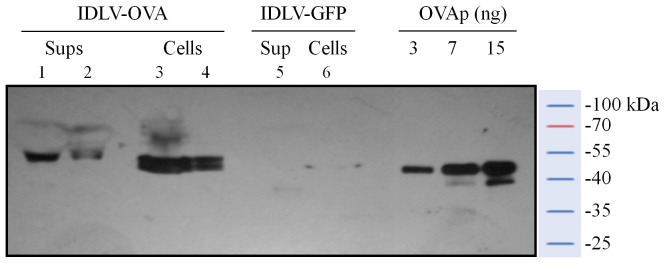
Expression of ovalbumin from IDLV.Western blot analysis of cell lysates and supernatants from 293T cells transduced with IDLV-OVA or IDLV-GFP as negative control, using an anti-OVA polyclonal antibody. Ovalbumin protein (OVAp, predicted size 47 kD) was used as positive control. Samples included supernatants showing secreted OVA (lane 1 and lane 2, 14 µl and 7 µl from 293T cells cultured at 5×105/ml, respectively), and cell lysates (lane 3 and lane 4, corresponding to 3×105 and 0.75×105 cells equivalent, respectively). Supernatants (lane 5, 14 µl) and cell lysates (lane 6, 3×105 cells equivalent) from IDLV-GFP transduced cells did not produce OVA. OVA protein (OVAp) at indicated amounts was used as positive control.